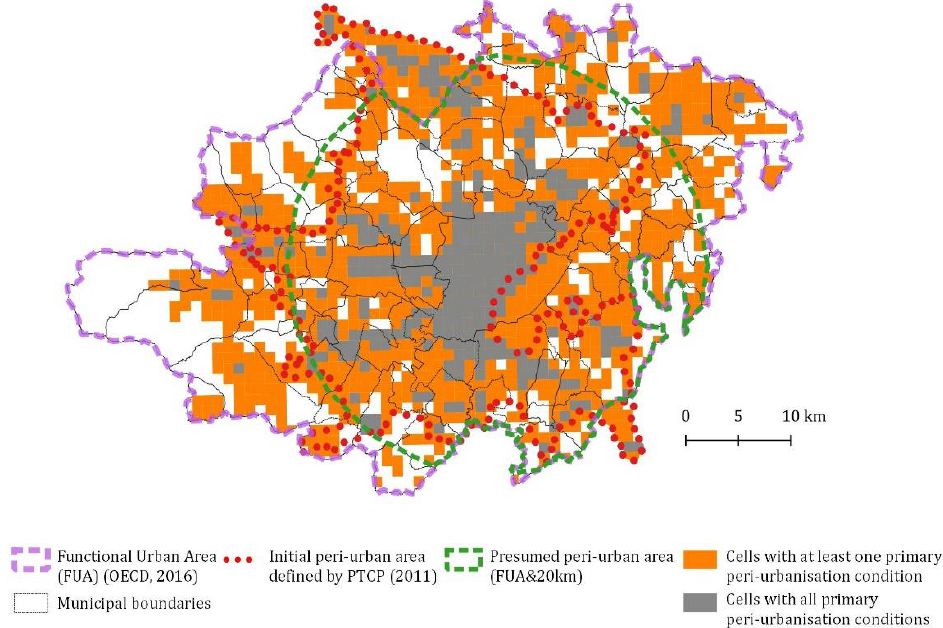
Figure 2. Identifying primary conditions for peri-urbanization in the TMA.